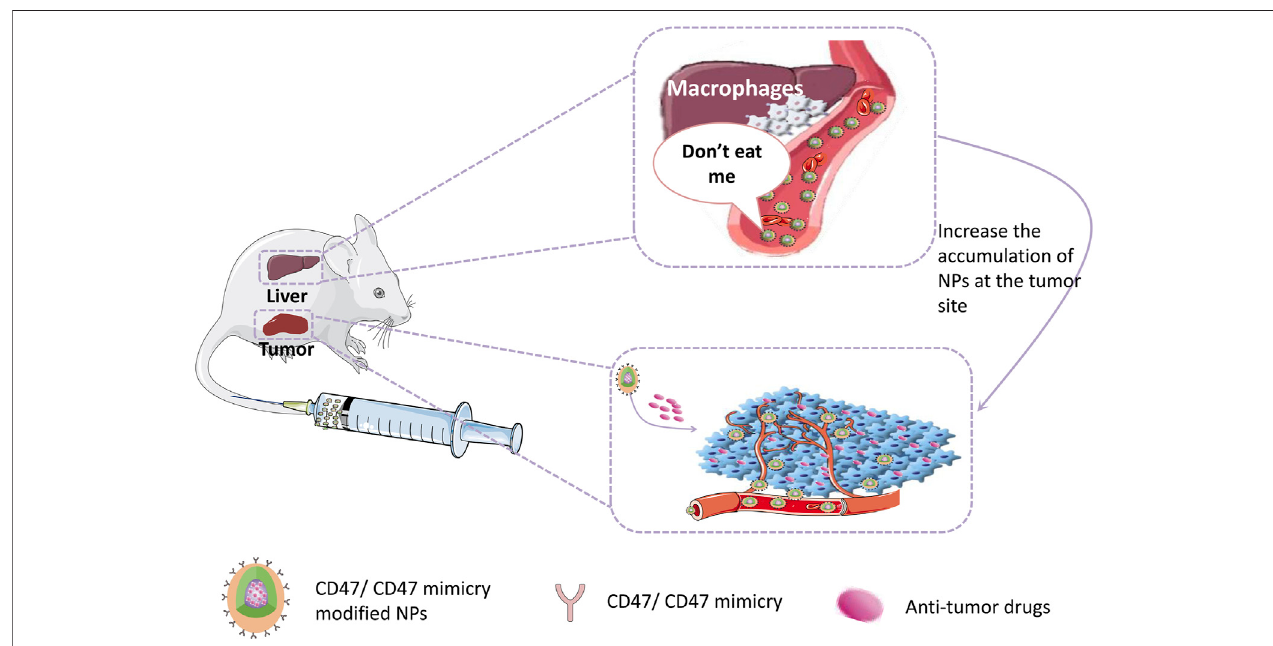
FIGURE 4 | CD47/CD47mimicry modi fi ed NPs can evade the phagocytic by reticuloendothelial system which increases their half-life in circulation and the accumulation at the tumor site, hence enhancing the therapeutic